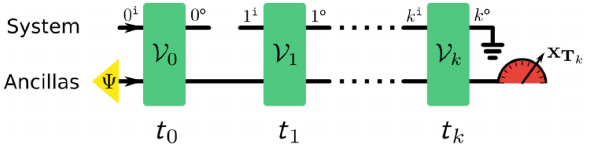
FIG. 19. Tester element. In the most general case, an experi- menter can correlate the system of interest with an ancilla (here, initially in state | (cid:23) (cid:16) ), use said ancilla again at the next time, etc., and make a final measurement with outcome x in the end. As the unitaries V j can also act trivially on parts of the ancilla, this scenario includes all conceivable measurements an experimenter amounts to trac- can perform. Summing over the outcomes x T k ing out the ancillas, thus yielding a proper comb (compare with Fig. 16). Note that the inputs (outputs) of the resulting tester ele- ments correspond to the outputs (inputs) of the process tensor, and the system of interest corresponds to the top line, not the bottom